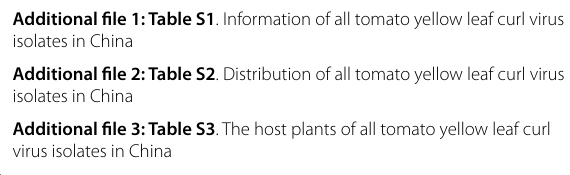
Additional file 2: Table S2 . Distribution of all tomato yellow leaf curl virus isolates in China Additional file 3: Table S3 . The host plants of all tomato yellow leaf curl virus isolates in